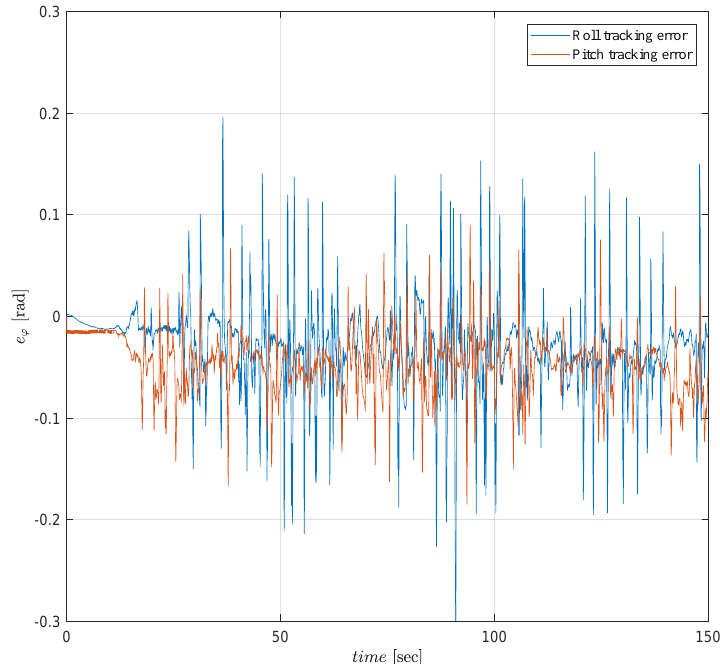
Figure 10. Attitude tracking error of the Qball-X4 using a Complementary filter.